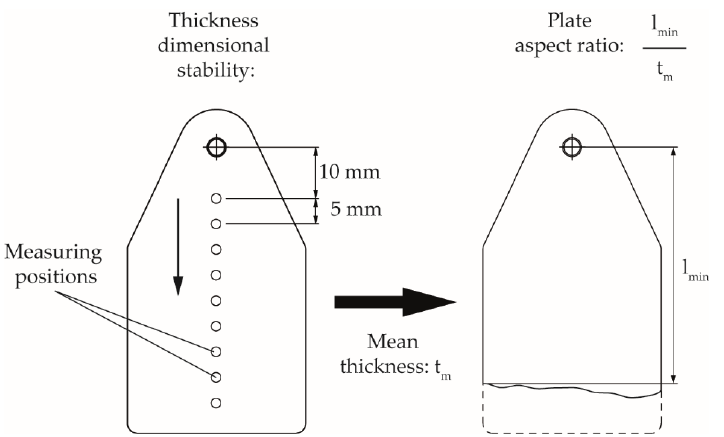
Figure 4. Measurement points for the investigation of the thickness dimensional stability and the plate aspect ratio.